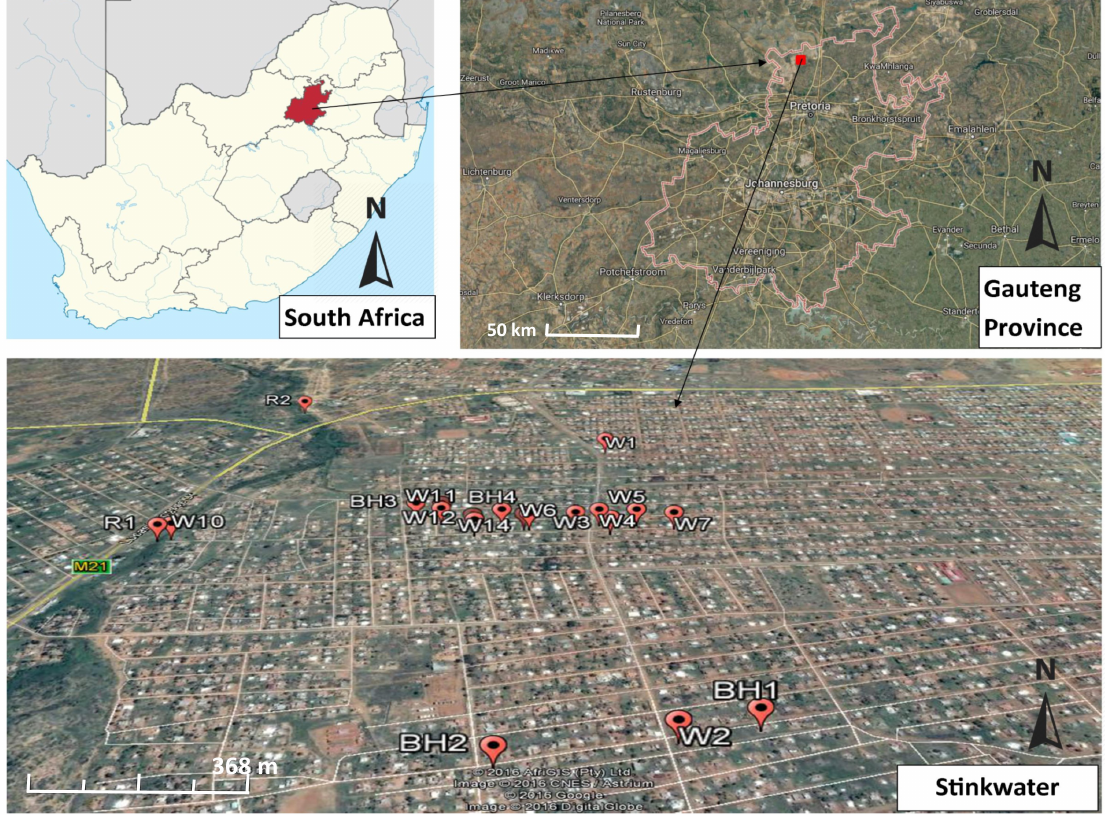
Figure 1. Map of the study area showing sampling points (Source: Google earth). W: well; BH: borehole; R: river (sample